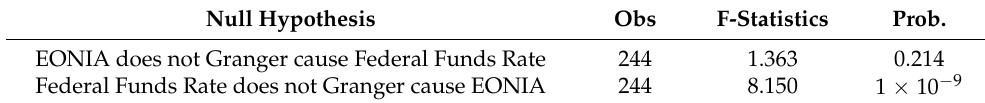
Table 1. Granger Causality Tests. Null